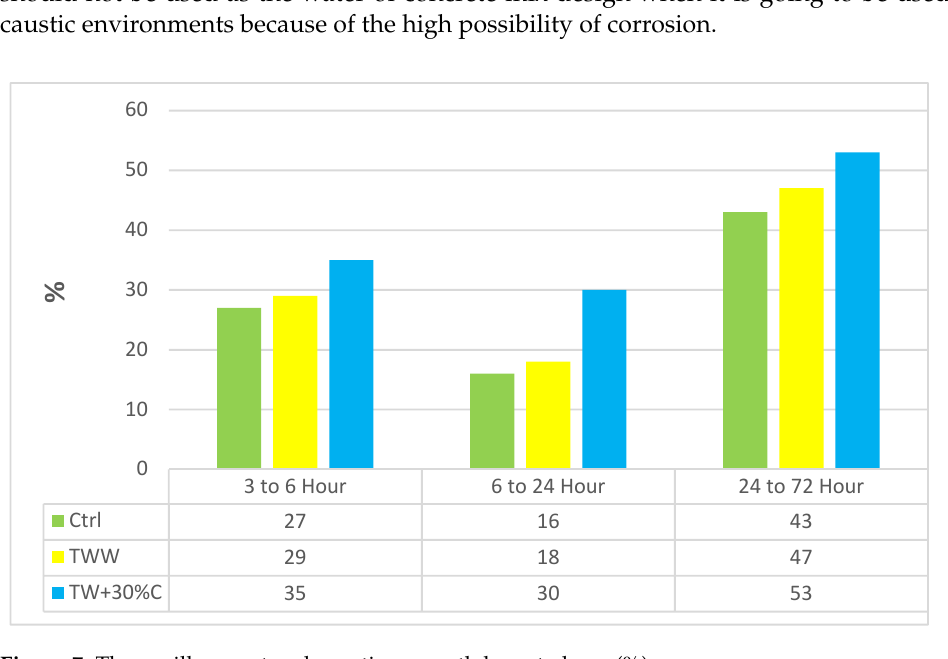
Table 7. The results of capillary water absorption ( gr